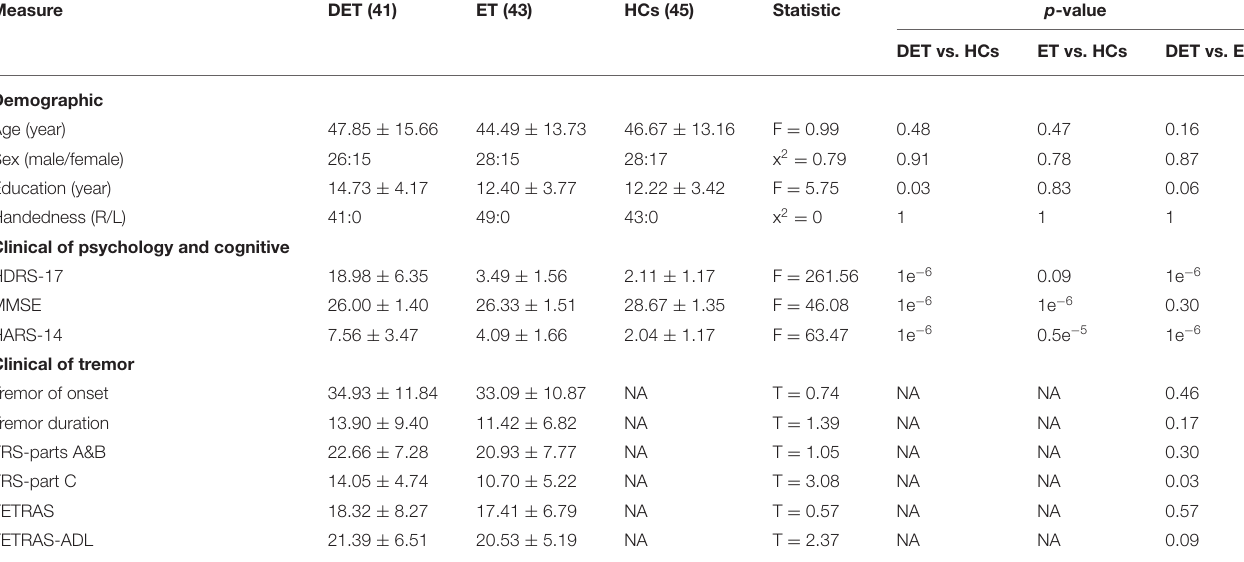
TABLE 1 | Demographic and clinical features of depressed ET, non-depressed ET, and HCs.